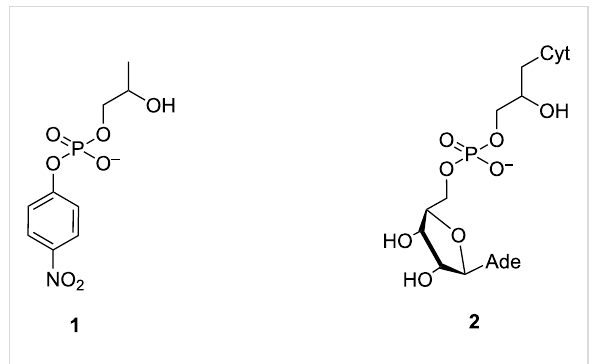
Figure 5: Structures of acyclic analogs of ribonucleosides.